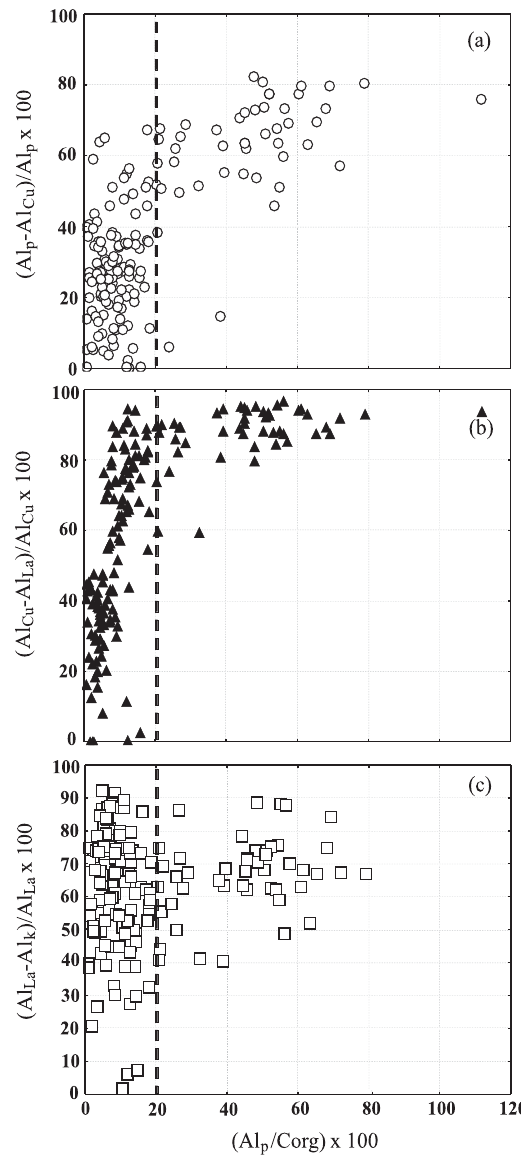
Figura 8. Relação entre (Al /Corg) x 100 e (a) ((Al - p p /Al ) x 100, (b) ((Al -Al )/Al ) x 100 e (c) Al Cu p Cu La Cu ((Al -Al )/Al ) x 100 para o conjunto de La K La amostras com valores positivo ou nulo da diferença entre extratores. Amostras de horizontes Bs, Bhs e C são predominantes para valores de saturação por Al no húmus superiores a 20 (linha tracejada), as quais detêm as formas mais estáveis da associação